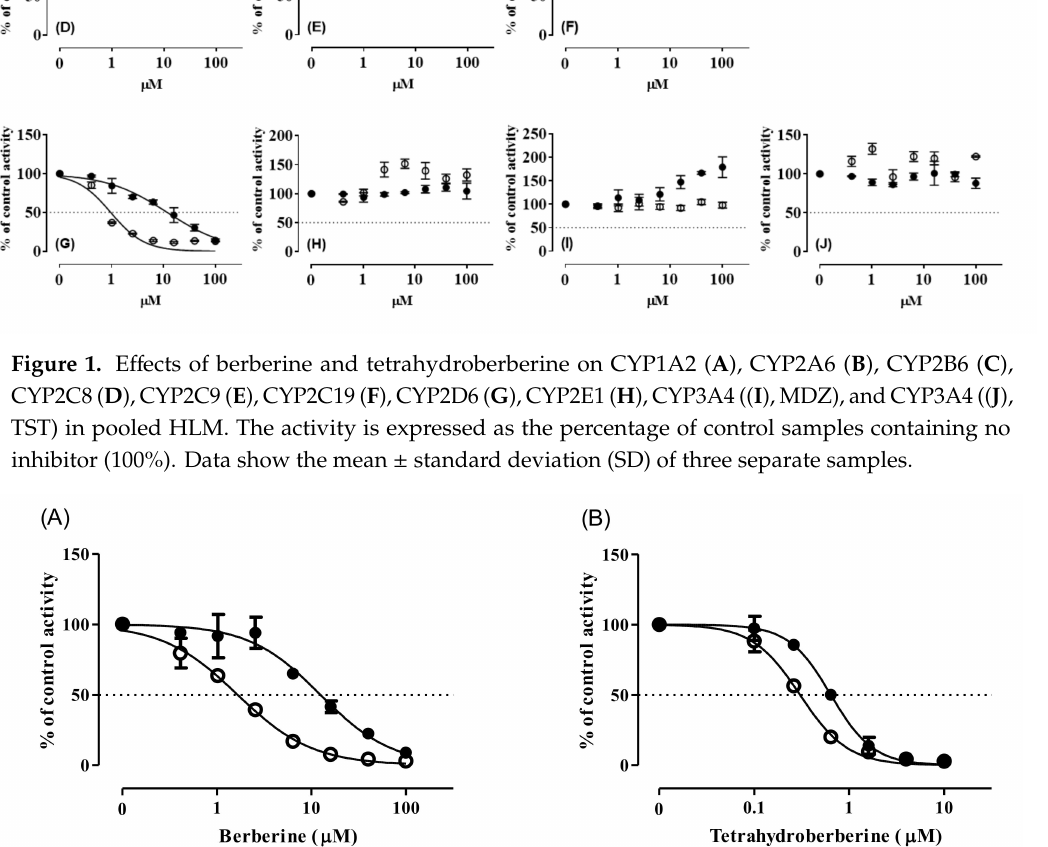
Figure 2. Changes in the inhibition curves of CYP2D6 by BBR ( A ) and THB ( B ) after pre-incubation of pooled HLM with (empty circle, ) or without (solid circle, • ) NADPH for 30 min. The activity (cid:35) is expressed as the percentage of control samples containing no inhibitor (100%). Data show the mean ± SD of three separate